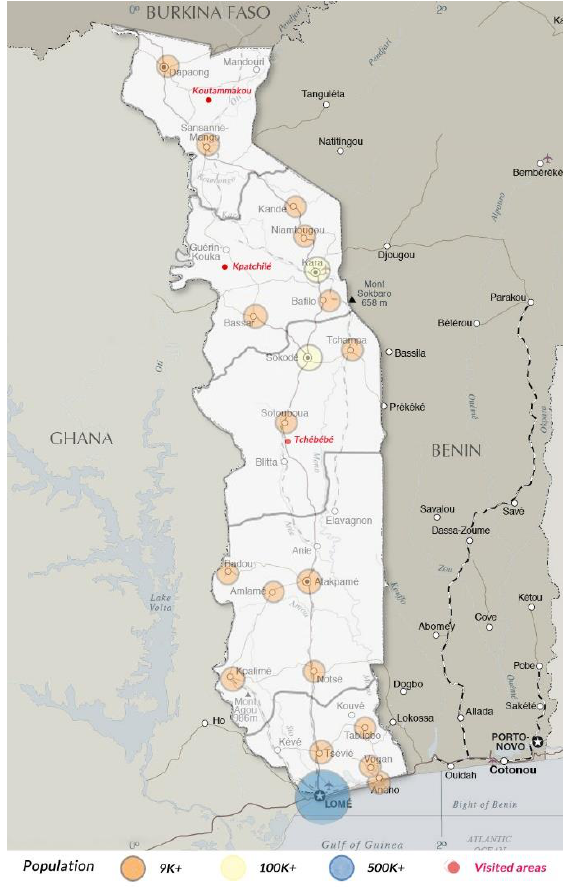
Figure 1.Urban areas and visited rural áreas.